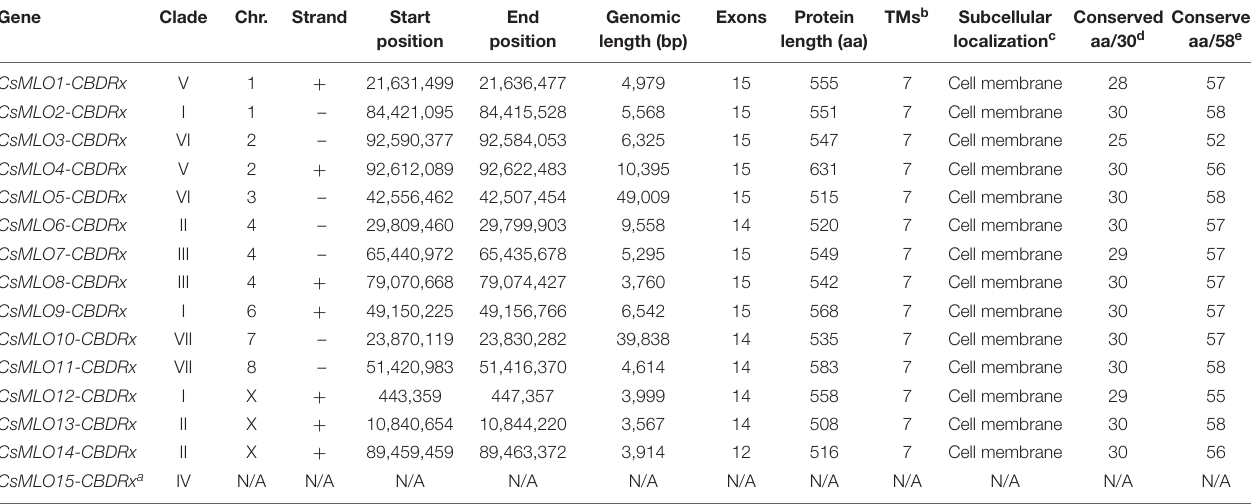
End Genomic Exons Protein TMs b Subcellular Conserved Conserved position position length (bp) length (aa) localization c aa/30 d aa/58 e